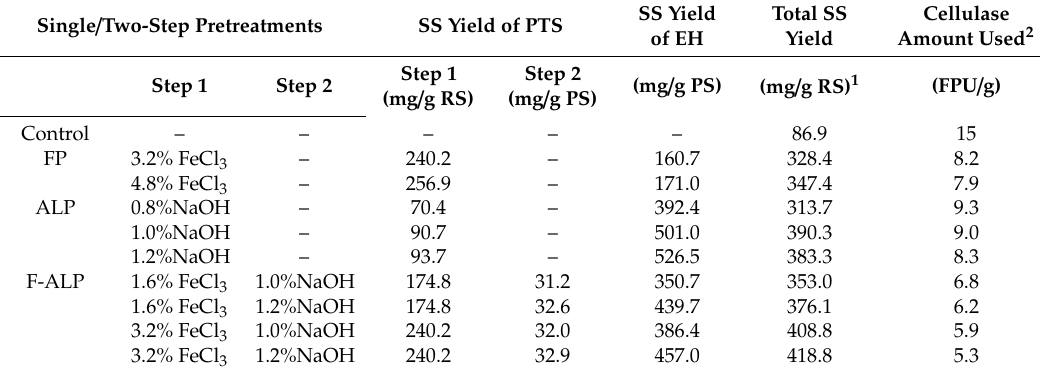
Table 2. Mass balance of the stalk